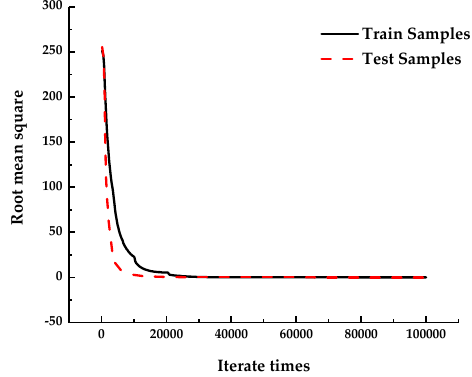
Figure 7. The RMSE of the network training.